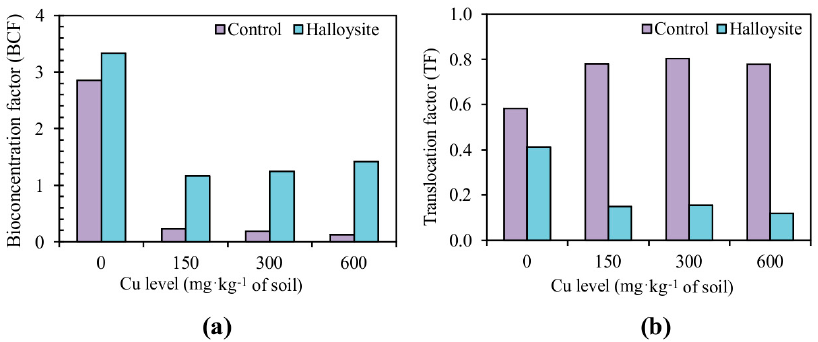
Figure 4. Effects of applying halloysite on copper accumulation (BCF) ( a ) and translocation (TF) ( b ) in F. rubra (grown in Cu-contaminated soil).